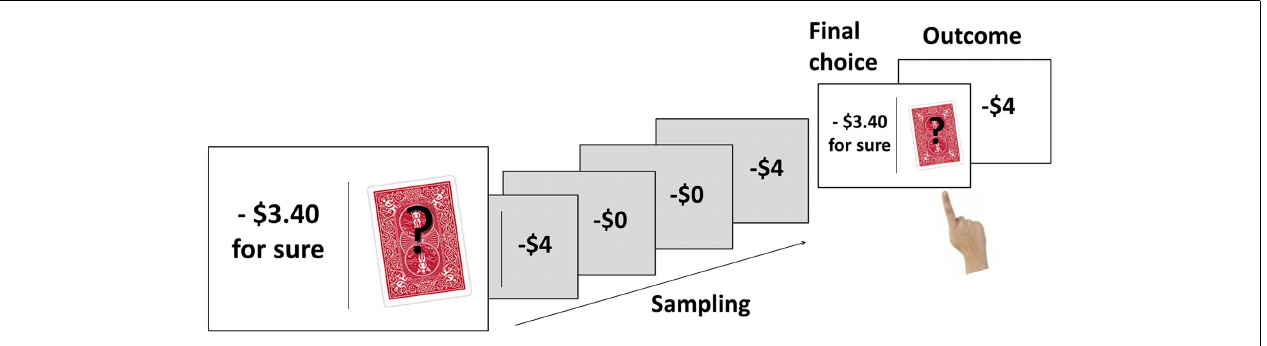
nothing with probability 0.20) is on the right.The participant samples the risky option four times and experiences both outcomes twice.The participant’s final choice is the risky option, resulting in a $4